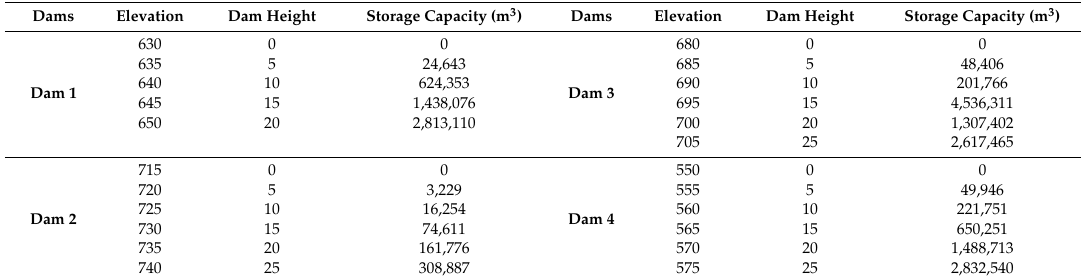
Table 3. The details of storage capacities of the proposed